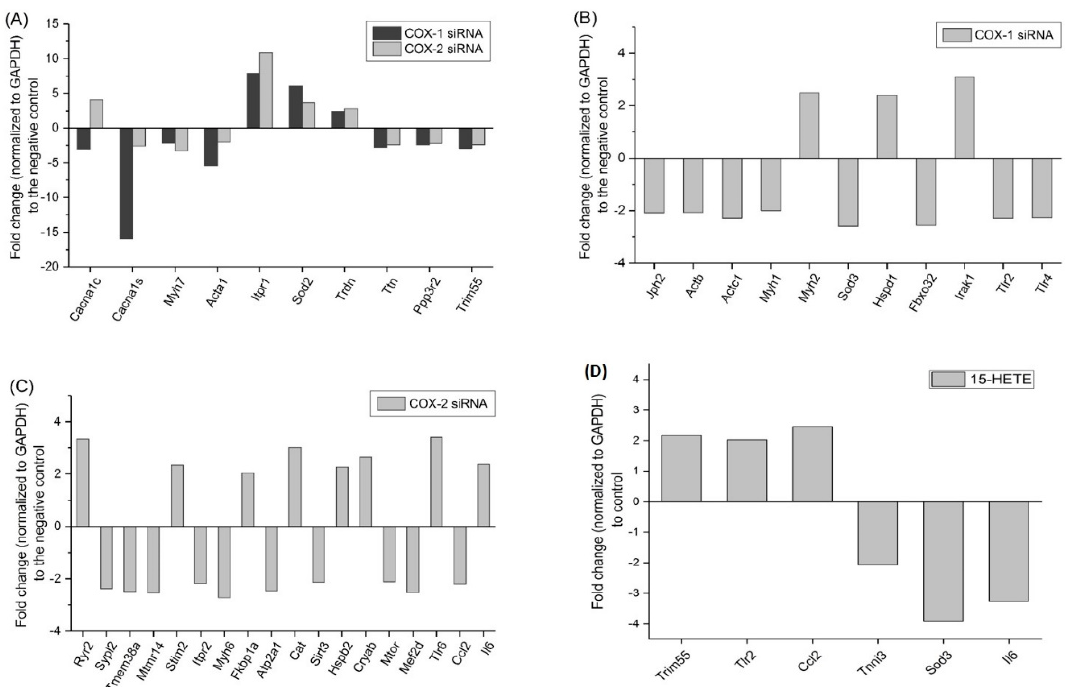
Figure 7. Knocking down COX-1 or -2 affects the expression of genes related with muscle structure and functions. ( A ) Genes affected by both COX-1 and COX-2 siRNA transfection; ( B ) genes affected by COX-1 siRNA transfection only; and ( C ) genes affected by COX-2 siRNA transfection only. ( D ) Changes in gene expression after treatment with 15-HETE for 48 h. Only genes with two-fold or greater changes, which are considered as significant changes, are listed.